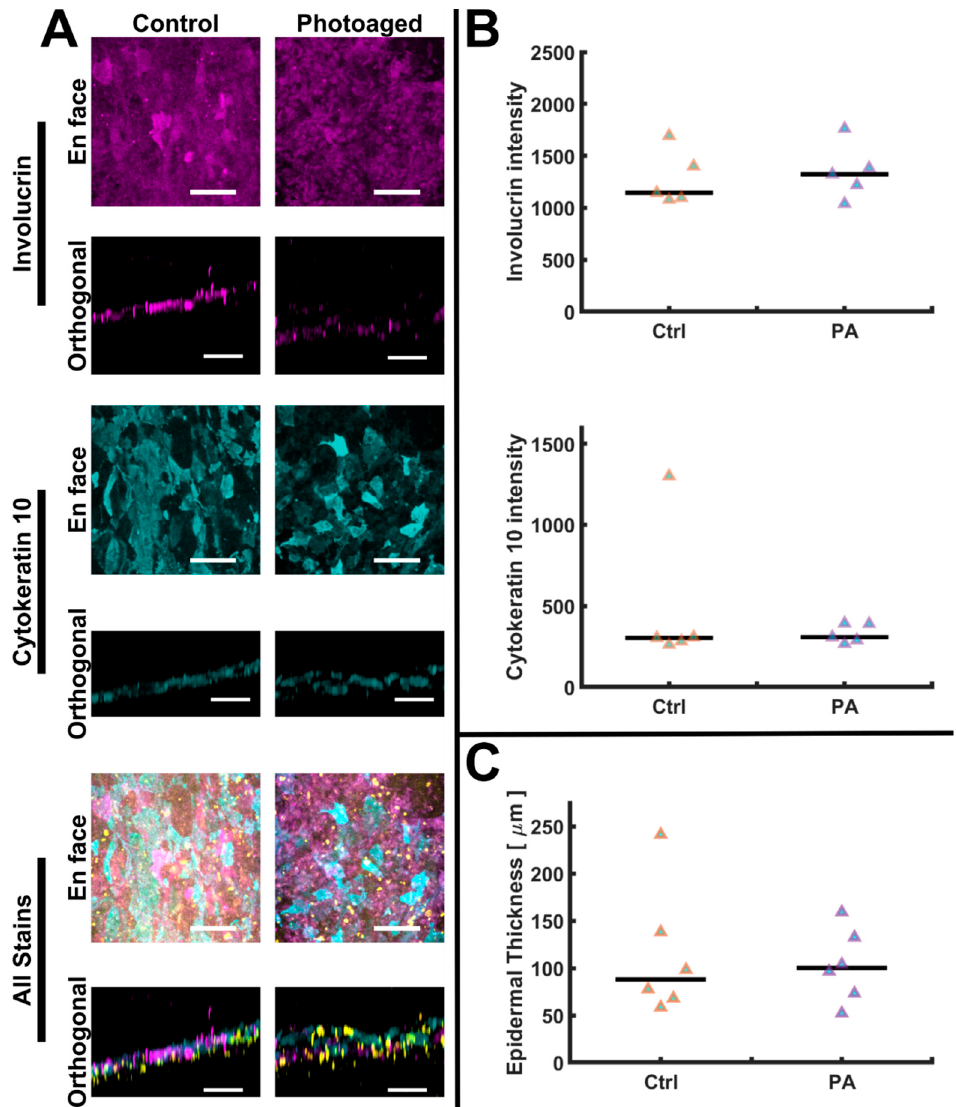
Figure 4. Epidermal characterization and quantification. ( A ) The epidermal differentiation markers, Involucrin (magenta) and Cytokeratin 10 (cyan), localize to epidermis. Nuclei are marked with a DRAQ7 counterstain and shown in yellow. No apparent qualitative changes in the experimental groups were observed, as shown in these representative images. Scalebars are 100 µm. ( B ) Quantification of epidermal intensities was completed from z-axis maximum projections; no indication of intensity changes was found in either epidermal stain when comparing control (Ctrl) to photoaged (PA) samples. For both control and photoaged groups n = 5. ( C ) Epidermal thickness was volumetrically quantified and no differences were indicated ( n = 6 for both control and photoaged groups). Data is shown as medians (black bars) and individual data points (triangles). Images were acquired pre-clearing and are median filtered for clarity.